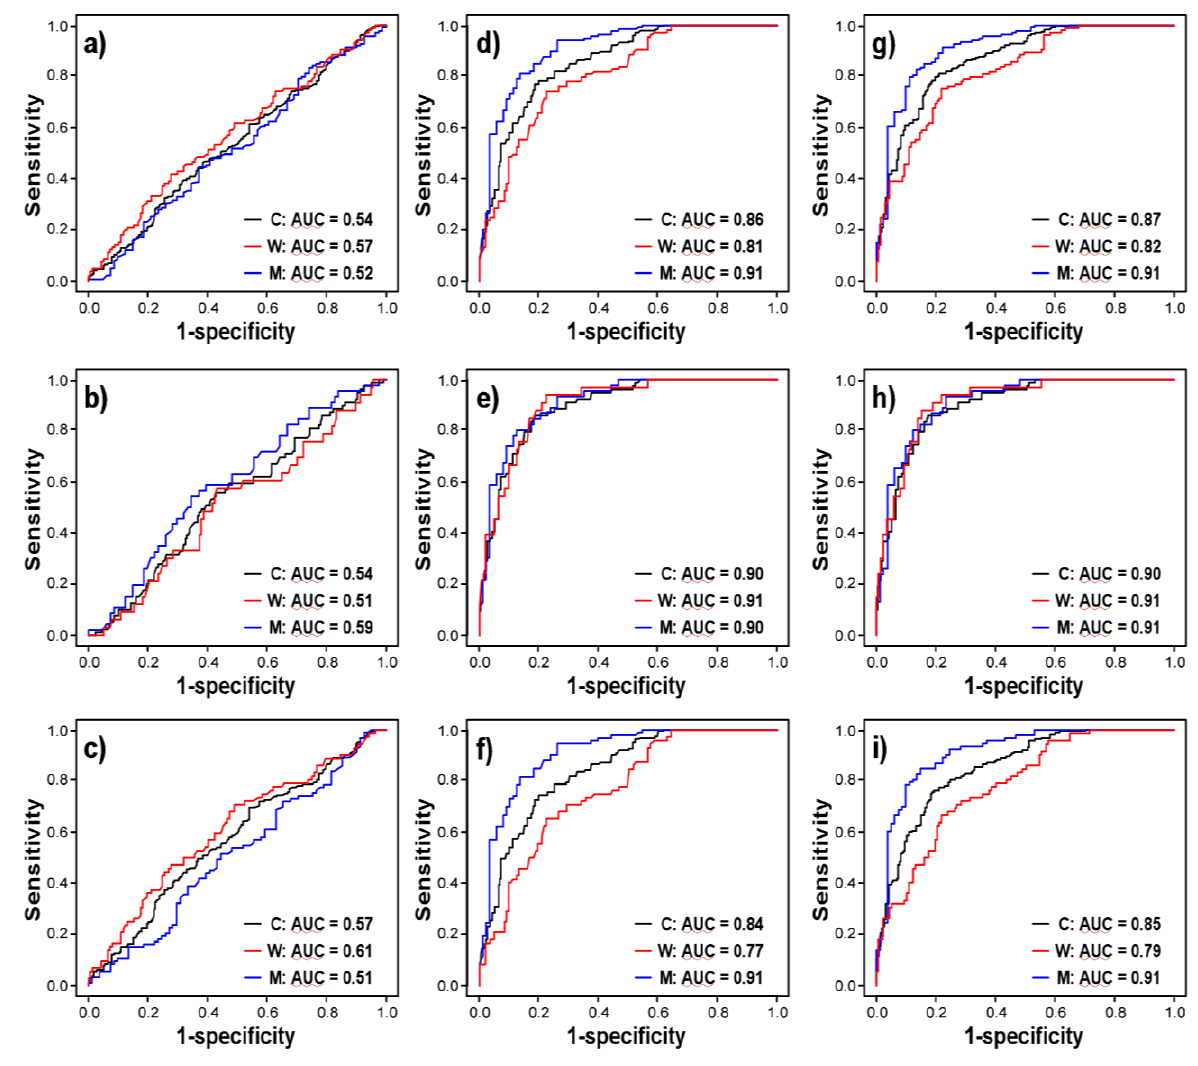
Figure 4. Receiver operating characteristic curves of lung cancer cases vs. controls. ROC curves are shown comparing all cancer cases vs. healthy controls ( a , d , g ), SCC vs. healthy controls ( b , e , h ), and adenocarcinoma vs. healthy controls ( c , f , i ). ROC curves are shown for a reduced model of log-transformed sHER2 concentrations alone (a, b, c), a model of age alone (d, e, f), and a model including both age and log-transformed sHER2 concentrations (g, h, i) for both men and women combined (black ROC curves labeled C), men only (blue ROC curves labeled M), and women only (red ROC curves labeled